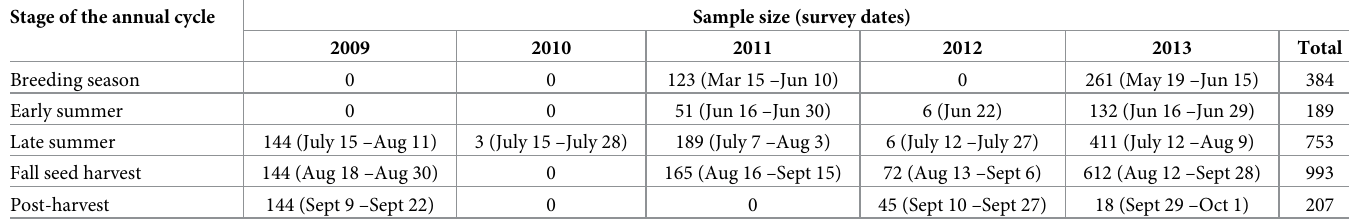
Table 1. Number and dates of surveys during each stage of the annual cycle.